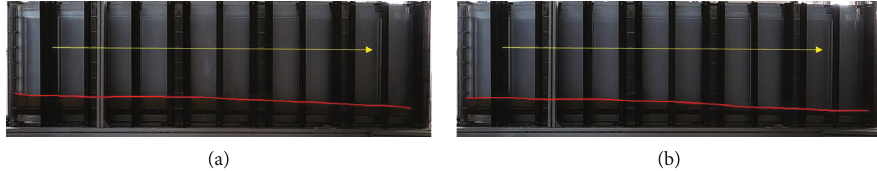
Figure 13: Sand embankment placement morphology in the evaluation experiment of tight gas layer: (a) the 12th group experiment and (b) the 13th group experiment.